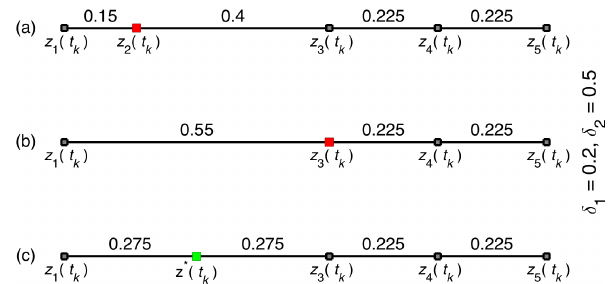
Figure 1. An illustration of the remeshing process with δ 1 = 0 . 2 and δ 2 = 0 . 5: for invalid mesh (a) , remove z 2 (t k ) , which violates δ 1 (b) , and insert z ∗ (t k ) to avoid violating δ 2 (c) .